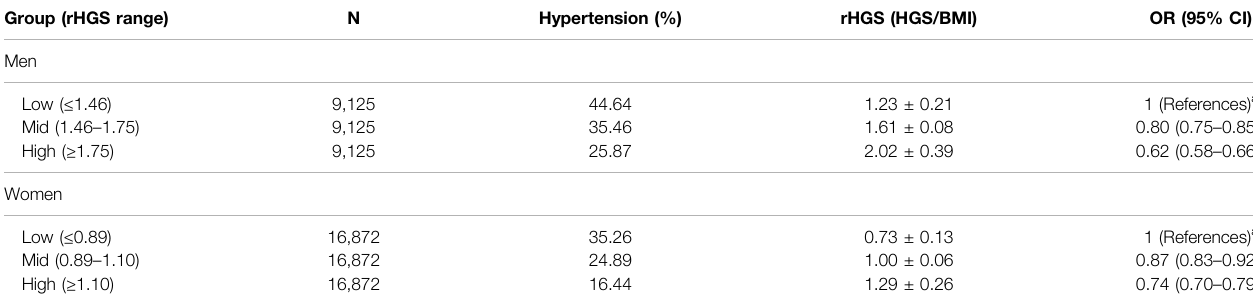
TABLE 2 | Odds ratios for hypertension according to sex-speci fi c tertiles of rHGS. Group (rHGS range) N Hypertension (%) rHGS (HGS/BMI)